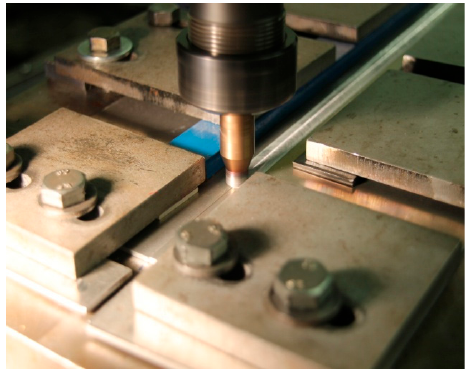
Figure 1. Friction stir welding process.